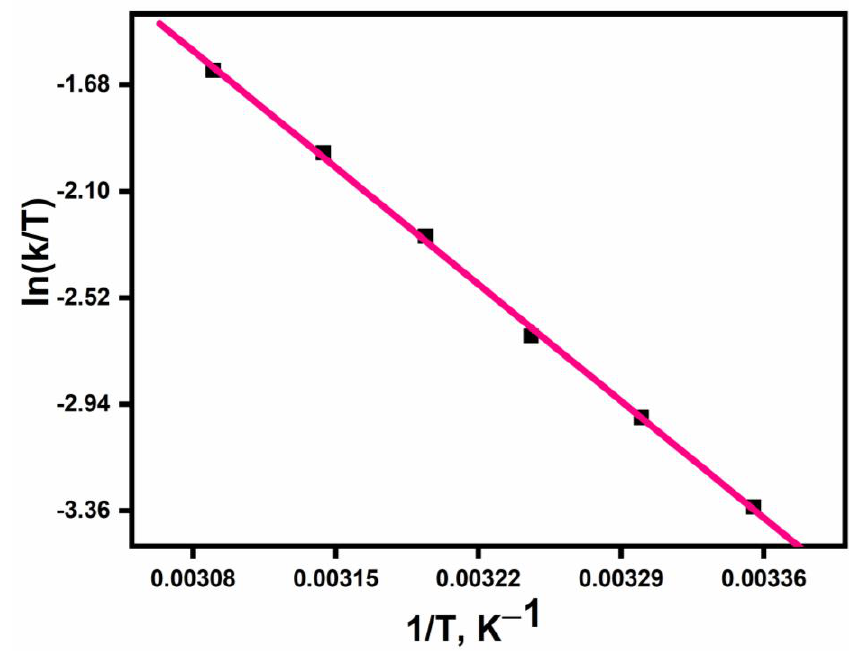
Figure 3. Eyring plot for cis-[Co(ip) 2 (C 12 H 25 NH 2 ) 2 ](ClO 4 ) 3 in DPPC medium. [Complex] = 4 × 10 − 4 mol dm − 3 ; [Fe 2+ ] = 0.01 mol dm − 3 ; [μ] = 1.0 mol dm − 3 .